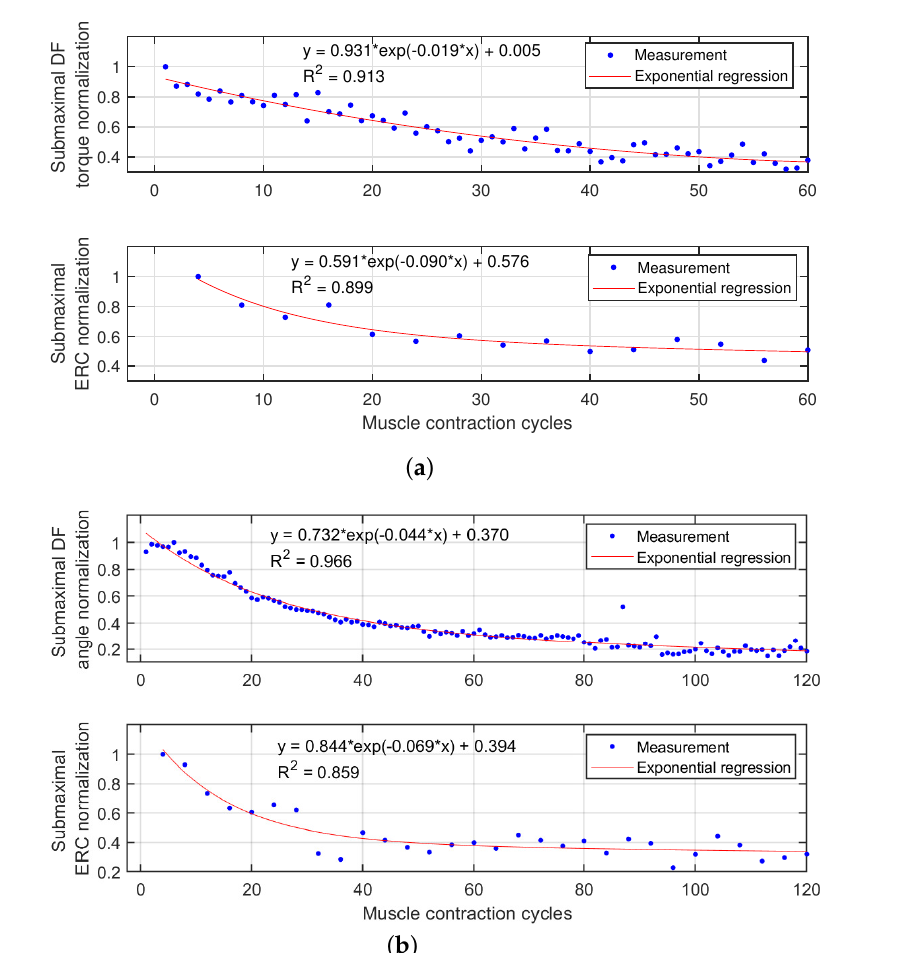
Figure 6. Results of the last data point of each recorded stimulation cycle, including the isometric dorsiflexion torque normalization, dynamic dorsiflexion angle normalization, and US ERC normaliza- tion on Participant Sub03. Furthermore, this figure includes the exponential regression equations and R 2 values of each variable decay curve along with the muscle contraction number. ( a ) Last data point of normalized dorsiflexion torque and ERC in each recorded stimulation cycle under the isometric condition. ( b ) Last data point of normalized dorsiflexion angle and ERC in each recorded stimulation cycle under the dynamic condition.